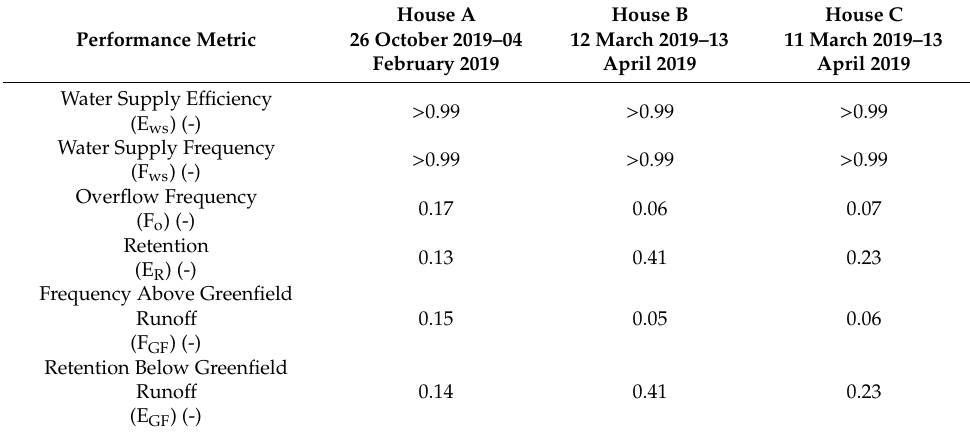
Table 3. Short-term water supply and stormwater management performance.